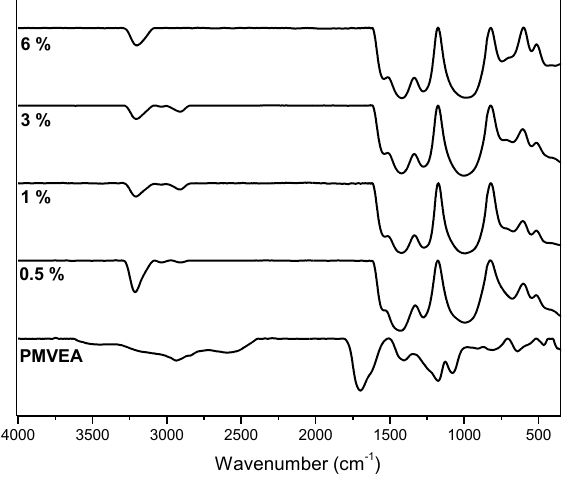
Figure 5. IR spectra of PMVEA and PANI nanofibers at different wt % of PMVEA.